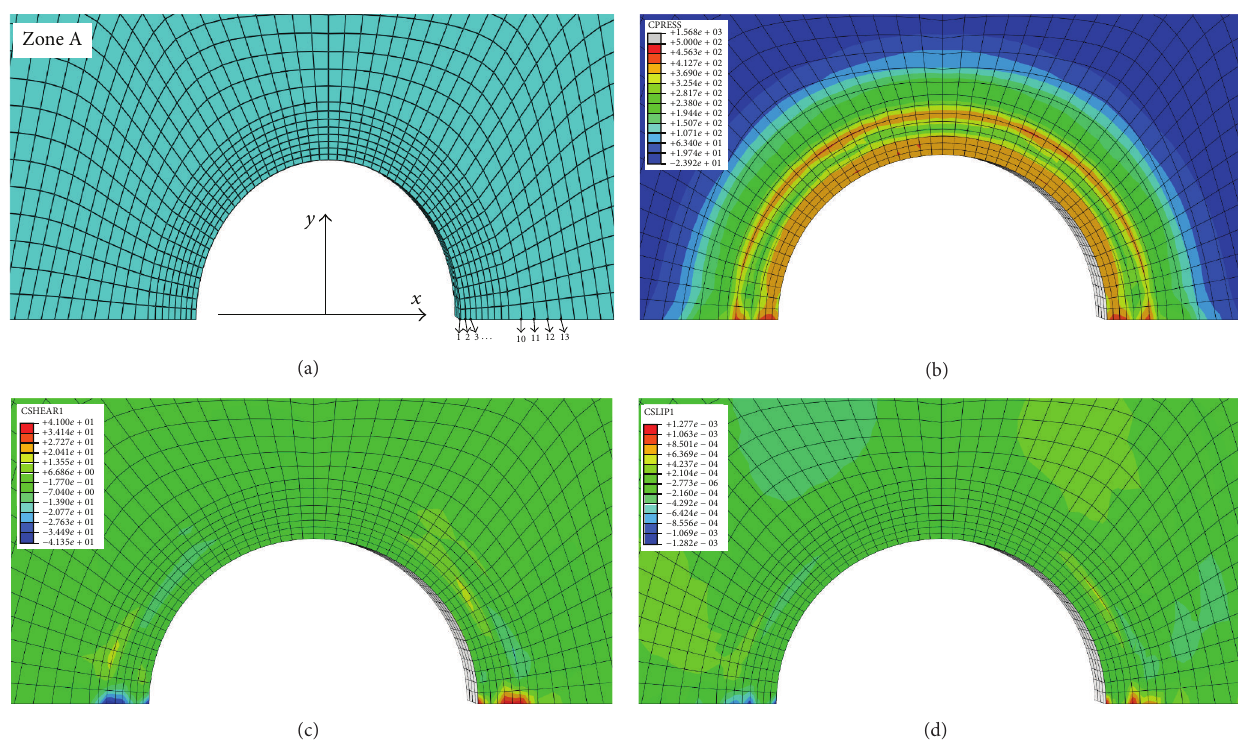
Figure 8: Contact stress and slipping distribution on the contact surface between plates ( 𝜎 𝑡 = 175 MPa). (a) Node label; (b) normal contact compression stress; (c) tangential contact stress along to the loading direction ( 𝑥 -axis); (d) relative slipping